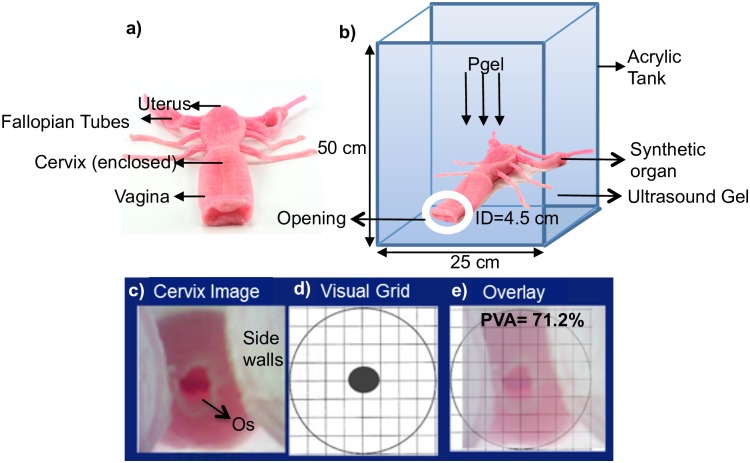
a) Vaginal organ model b) Schematic of phantom with vaginal organ suspended in acrylic tank and filled with gel. Pgel is pressure from the gel, ID is inner diameter of the opening. c) Cervix image from phantom showing central os and side walls d) Circular cervix grid for calculating percent visual area e) Cervix overlaid with circular grid with PVA calculated.